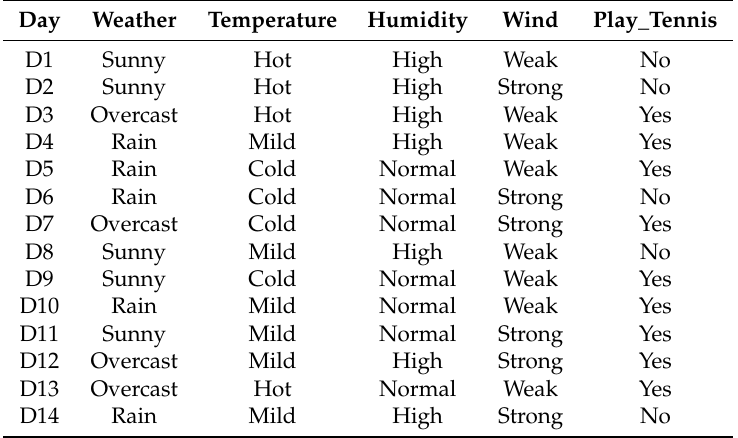
Table 2. The exemplary decision system-for rule induction